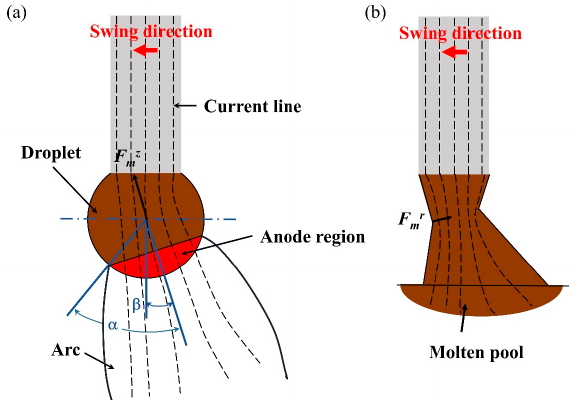
Figure 4. The electromagnetic force on the droplet: ( a ) formative stage; ( b ) transitional stage. I_boost and I_sc_wait) and α is the arc anode half angle. When the droplet comes into contact with the molten pool, the change in the droplet shape leads to a change in the current density, as shown in Figure 4b. At this moment, a radial electromagnetic force is generated at the necking, at which time the necking shrinks under the action of the radial electromagnetic force, thus promoting the droplet transition to the molten pool. The radial electromagnetic force ( F mr ) can be calculated according to Equation (3):